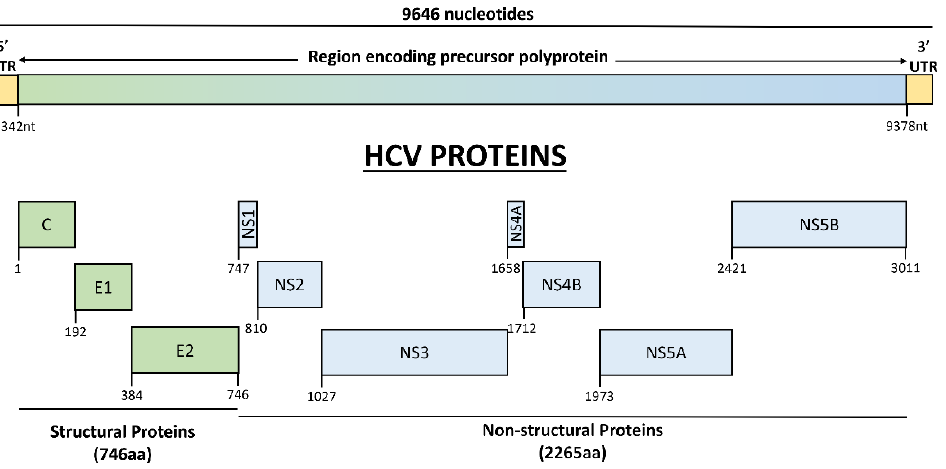
Figure 1. The organization of HCV genome and HCV transcribed proteins. The genome of HCV is composed of 9646 nucleotide bases. The central part of the genome is an open reading frame (ORF) of 9036 nucleotides flanked by 5 ′ (341nt) and 3′ (269nt) untranslated regions (UTRs). ORF encodes for a precursor polyprotein of 3011 nucleotides that is processed into 10 viral proteins. The three structural proteins are core protein (191aa) and two envelope glycoproteins (192aa and 363aa). The seven non-structural proteins show various lengths (NS1 63aa, NS2 217aa, NS3 631aa, NS4A 54aa, NS4B 261aa, NS5A 448aa, NS5B 591aa). UTR — untranslated region; C — core protein; E — envelope glycoprotein; NS — non-structural protein; nt — nucleotide; aa — amino acid.